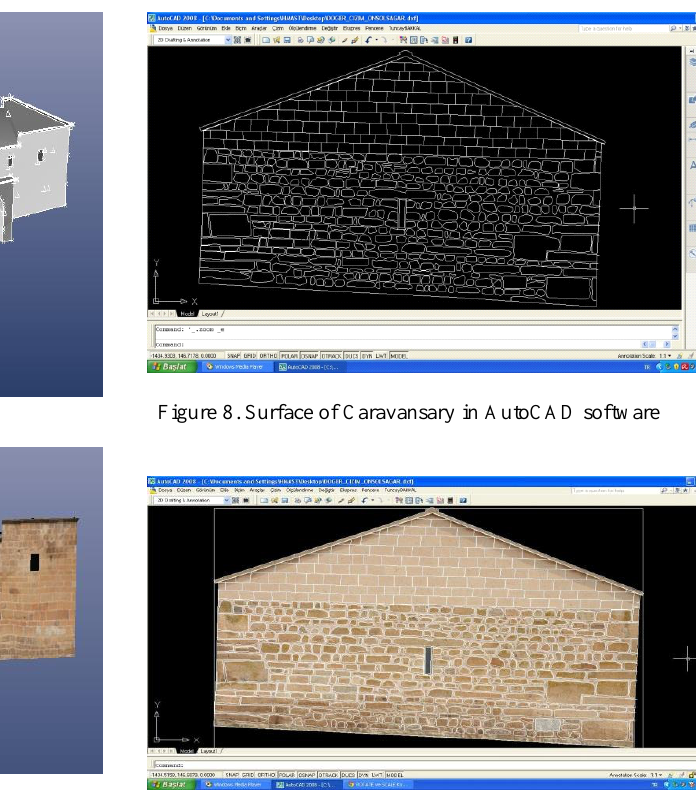
Figure 9. Orthophoto and drawing of surveys